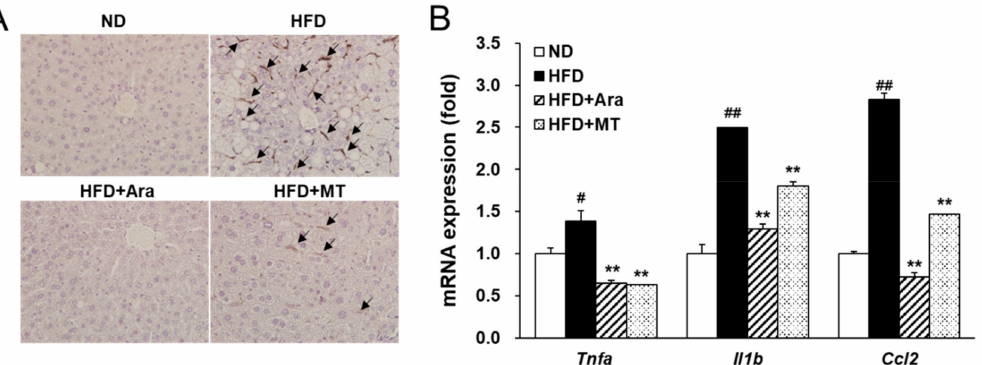
Figure 5. Arazyme suppressed steatohepatitis in HFD-fed NAFLD-like mice. ( A ) Liver sections immunohistochemically stained for F4 / 80 ( × 400 magnification). F4 / 80-positive macrophages were marked by black arrows. ( B ) The mRNA expression levels of inflammation-related genes in the liver were detected by real-time qRT-PCR. Data are presented as means ± SE ( n = 4). # p < 0.05, ## p < 0.01 vs. ND; ** p < 0.01 vs. HFD by one-way ANOVA. Tumor necrosis factor α ( Tnfa ), interleukin-1 β ( Il1b ), and chemokine ligand 2 ( Ccl2